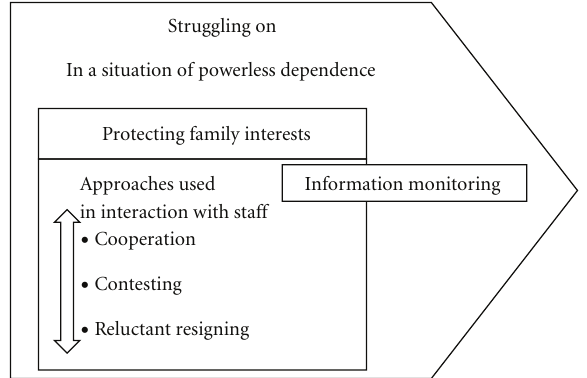
Figure 1: Approaches used by foreign-born parents in interaction with healthcare sta ff in a situation of powerless